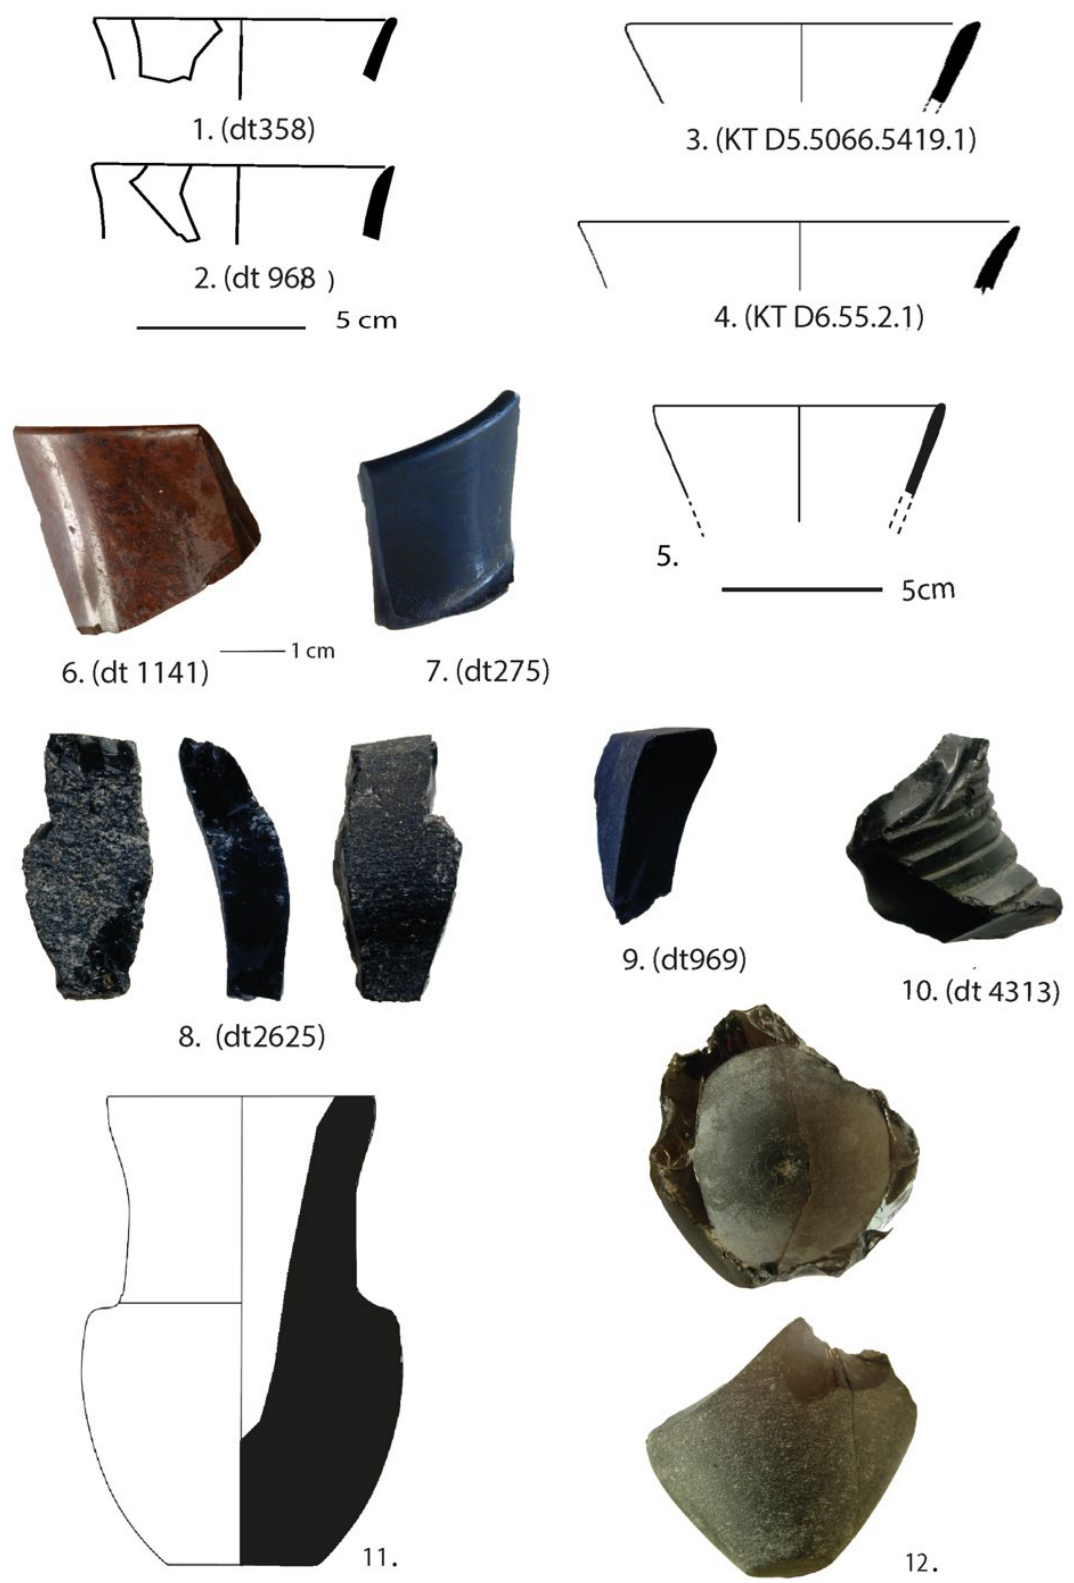
Figure 8. Obsidian cups and bowls of late Neolithic and Ubaid date. Nos. 1-2, 6-10 from Domuztepe (photographs and drawings courtesy of Stuart Campbell); nos. 3 and 4 from Kenan Tepe (drawings by the late Bradley Parker); No. 5 from Tülintepe (redrawn from Arsebük 1983); No. 13 from Tell Arpachiyah, 16 cm in height (redrawn from Mallowan & Rose 1935: fig. 44, 15); No. 12 bowl from Tell Zeidan, broken in the course of manufacture (photograph by the